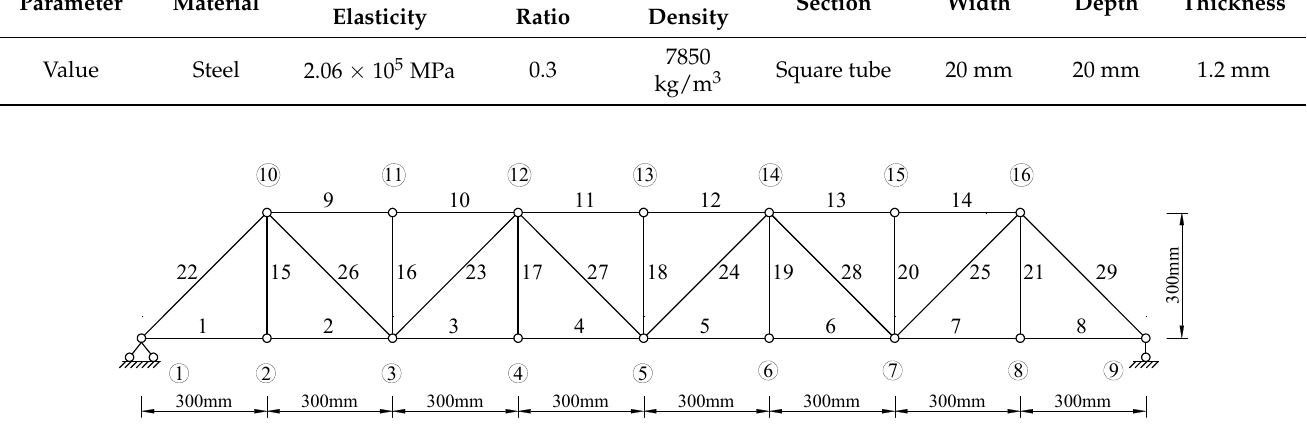
( i = 1 ∼ 29) for the experimental truss structure when bar element 5 is i